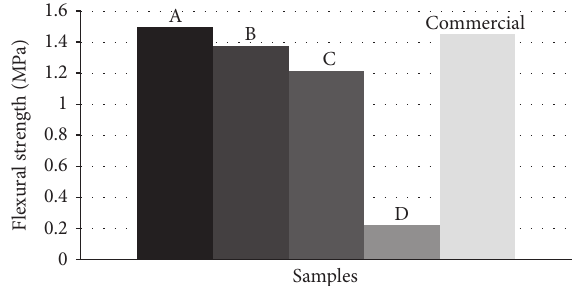
Figure 7: Flexural strength of lightweight cube concrete with different ratio of WLA to cement (wt/wt): (A) 55%, (B) 60%, (C) 65%, and (D)